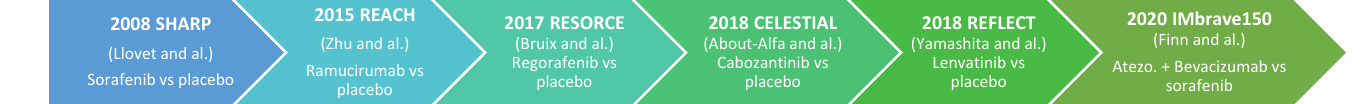
Figure 3. Historical timeline of systemic therapies approved in advanced hepatocellular carcinoma management [9,11,12,15,27,28].